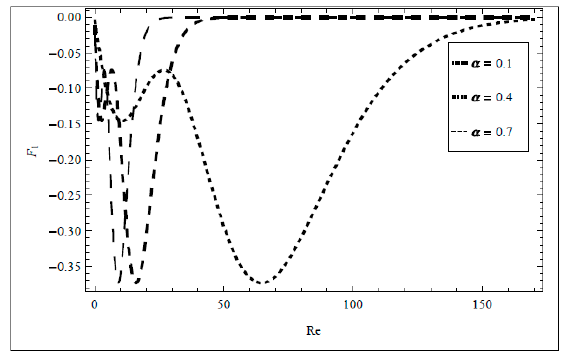
= 0.1. Coatings 2019 , 9 , x FOR PEER REVIEW